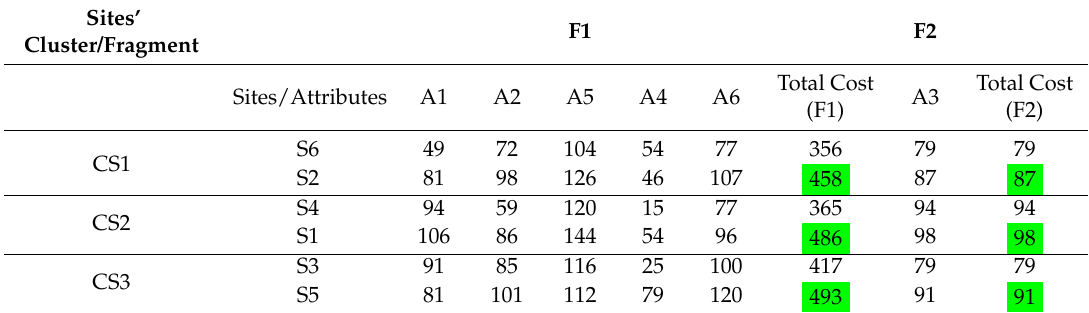
Table 15. Decision allocation matrix of this work.